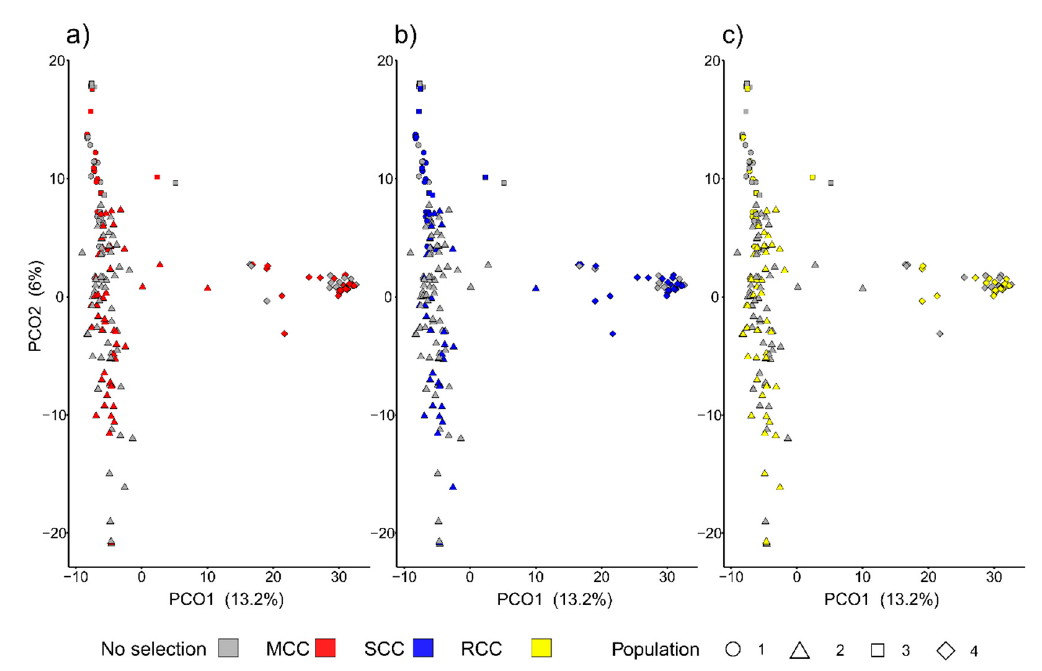
Figure 2. Biplot of the first two axes of the principal coordinate analysis according to Pascual et al. [27] showing the relative distribution of the primary set and core collections generated with ( a ) maximization strategy (MCC), ( b ) stratified sampling (SCC) and ( c ) random sampling (RCC). The genetic population is also indicated in the representation of the accessions.